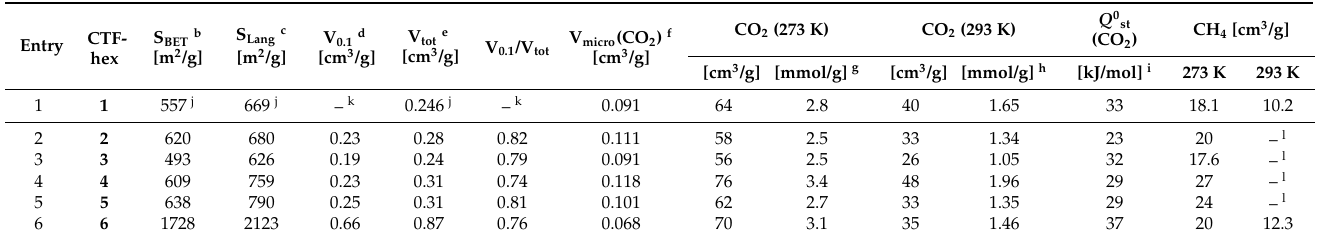
Table 2. Porosity data for the covalent triazine-based frameworks CTF-hex1 – 5 synthesized with TFMS and CTF-hex6 synthesized via ionothermal reaction conditions and carbon dioxide and methane uptake capacities; the corresponding adsorption–desorption isotherms are shown in the Supplementary Information a